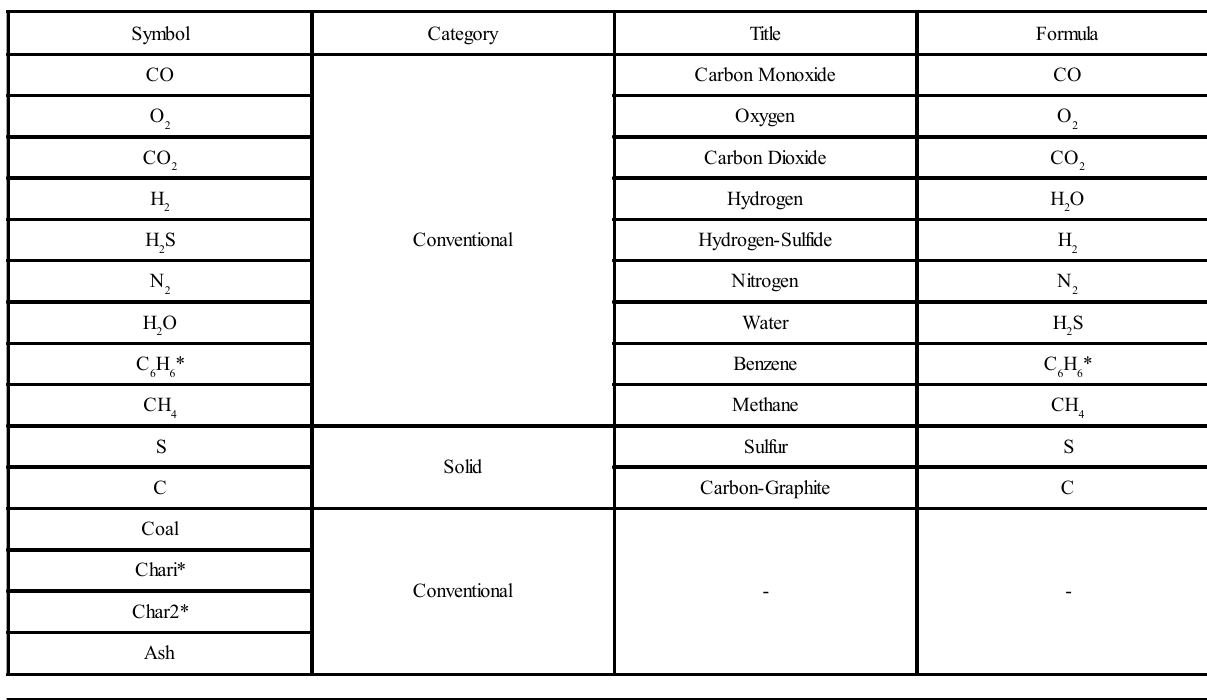
TABLE 1. THE USED OF COMPONENTS IN